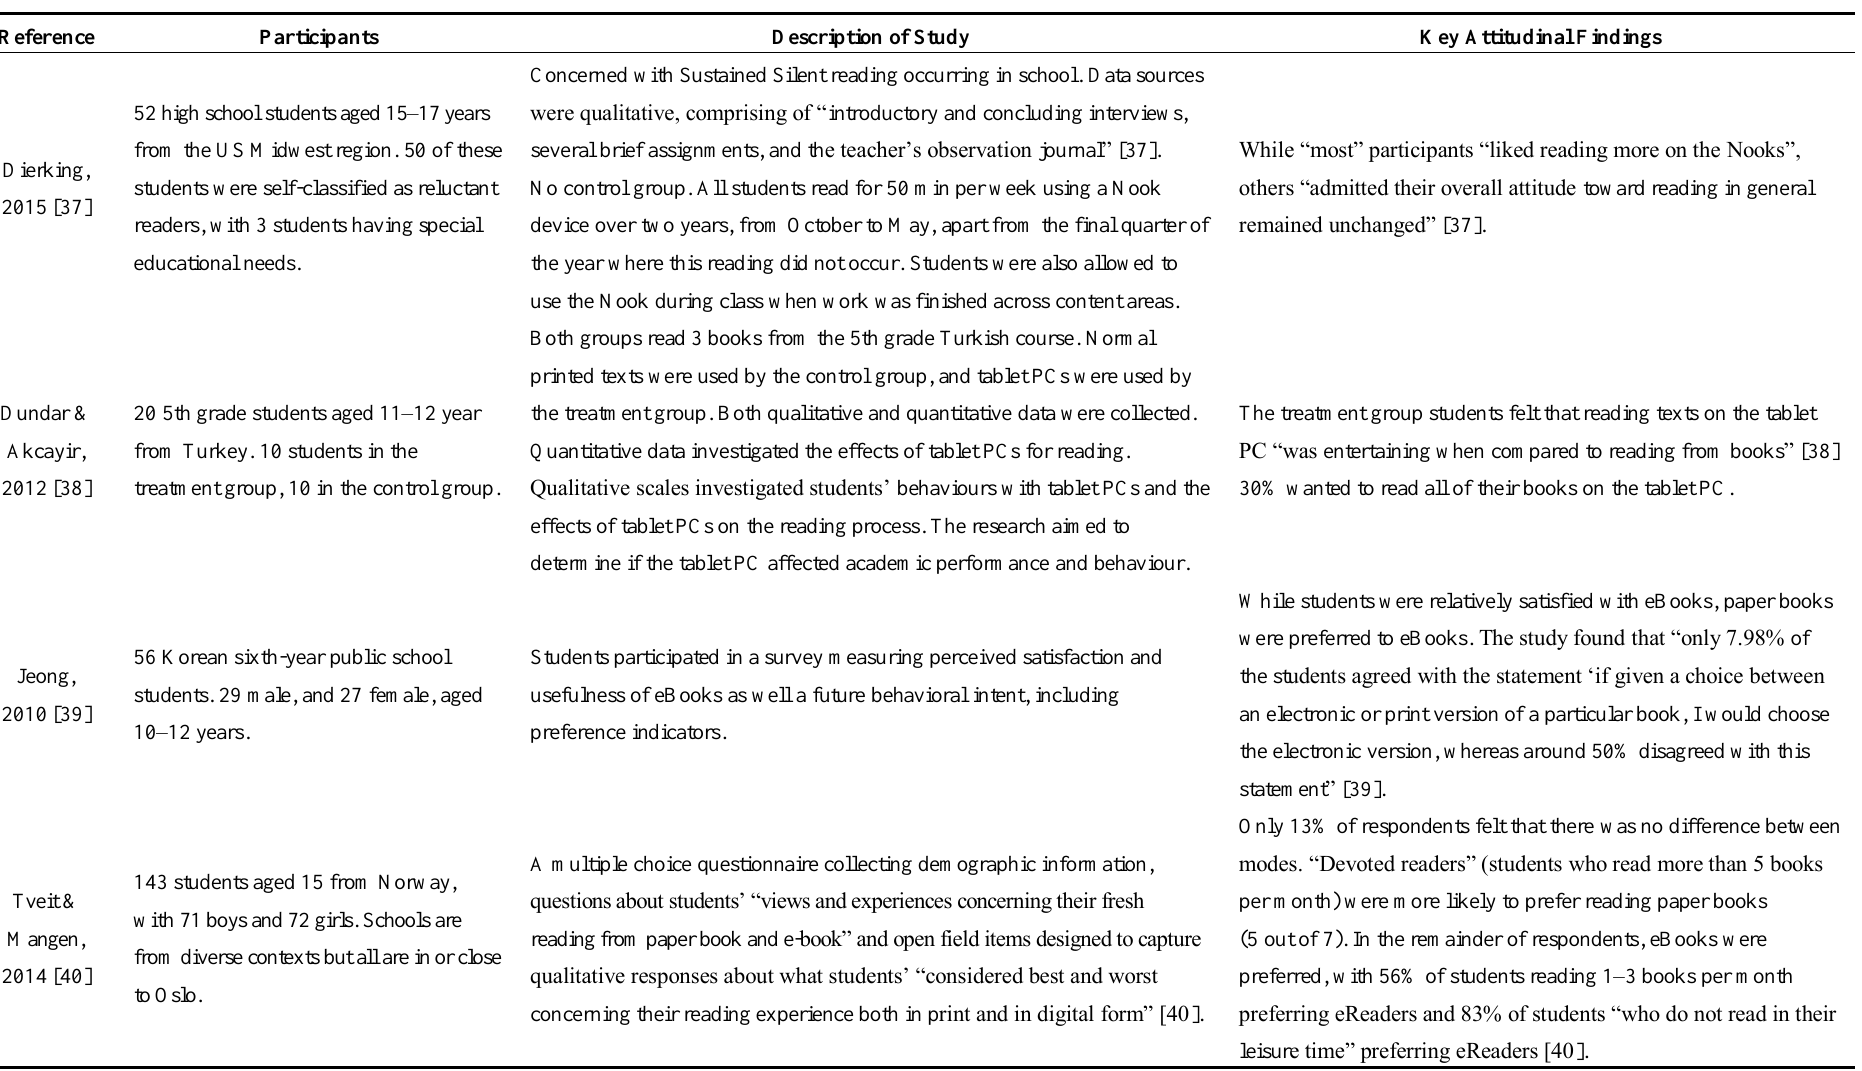
Table 1. Tabulated review of